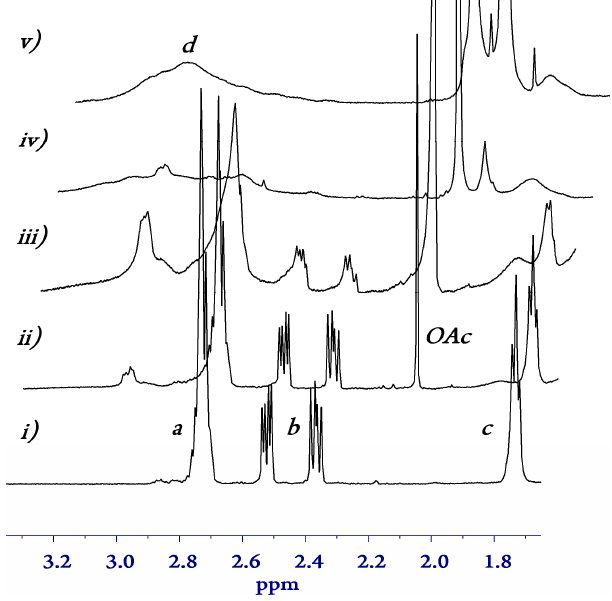
Figure 3. Results of 1 H-NMR spectroscopic titration of 1 with Pd(OAc) 2 . See Scheme 3 for signal assignment. Quantities of Pd(OAc) 2 : i ) 0 eq. ; ii ) 0.2 eq. ; iii ) 0.5 eq. ; iv ) 1 eq. ; v ) 2 eq.